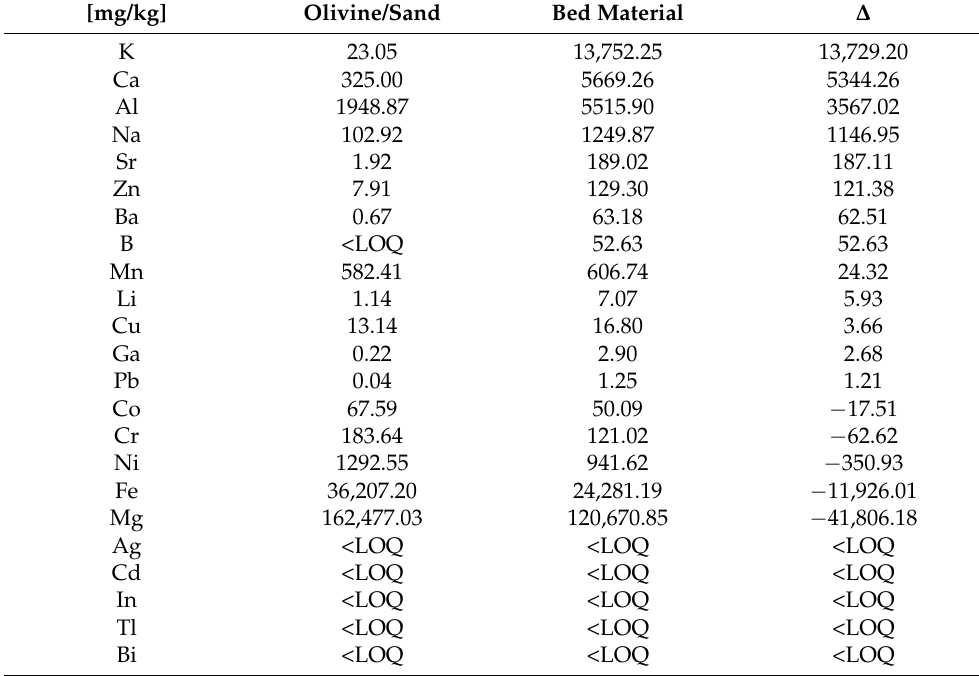
Table 5. Metal content in olivine before and after combustion